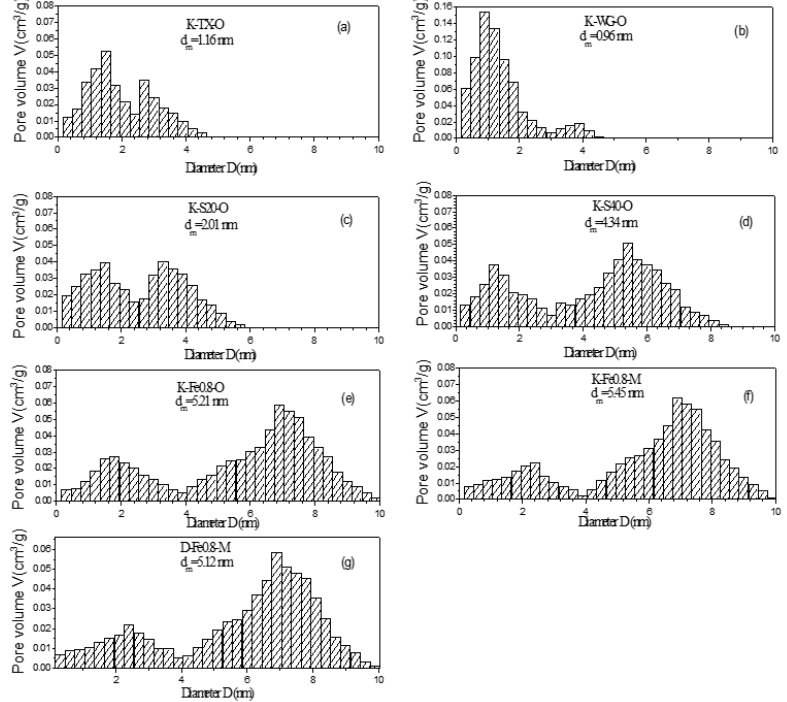
Figure 2. Pore diameter distributions for the samples of ( a ) K-TX-O, ( b ) K-WG-O, ( c ) K-S20-O, ( d ) K-S40-O, ( e ) K-Fe0.8-O, and ( f ) K-Fe0.8-M, derived from N 2 adsorption/desorption.